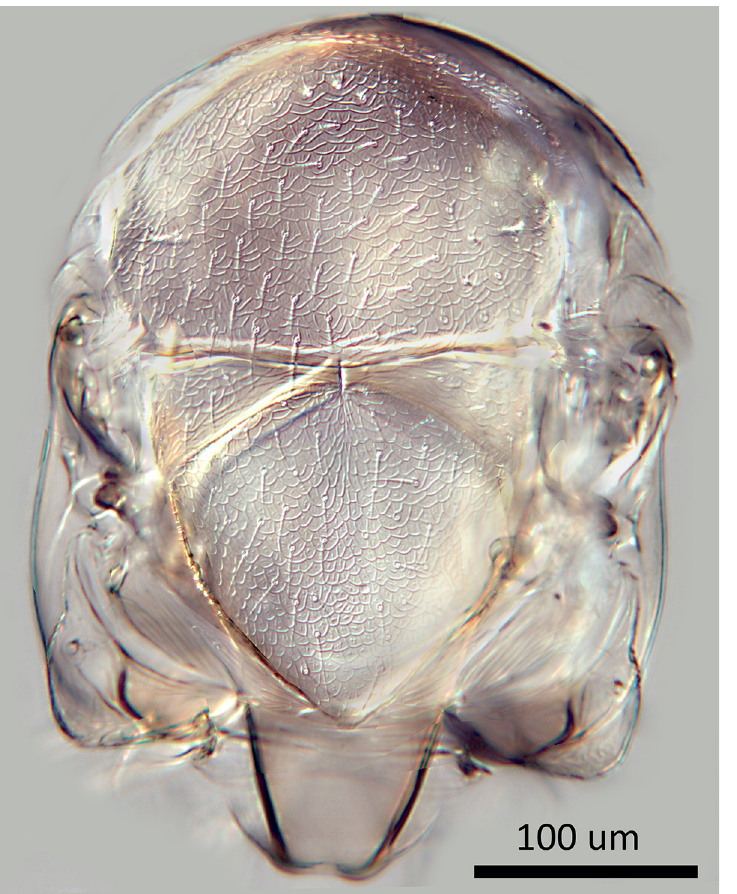
Fig 5. M . macadamiae female holotype, dorsal mesosoma.